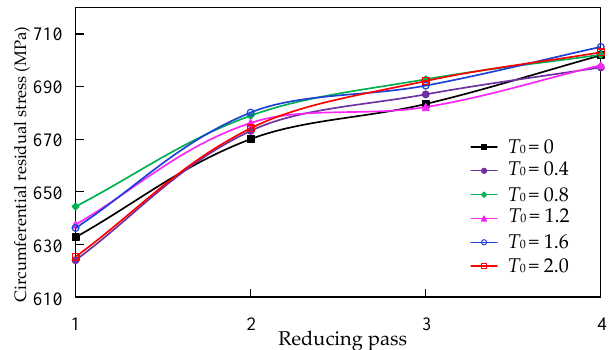
Figure 24. Circumferential residual stress of the end.